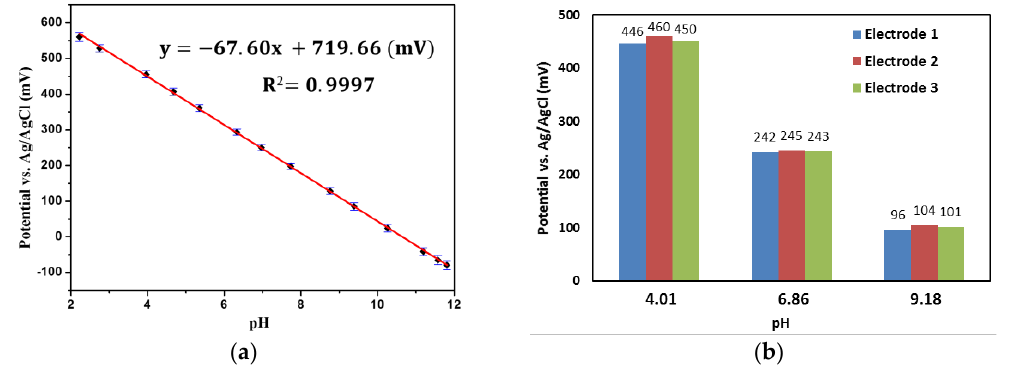
Figure 4. ( a ) Linear potential response of one pH sensing electrode from pH = 2.22 to pH = 11.81; and ( b ) potential responses of three electrodes in standard pH solutions.